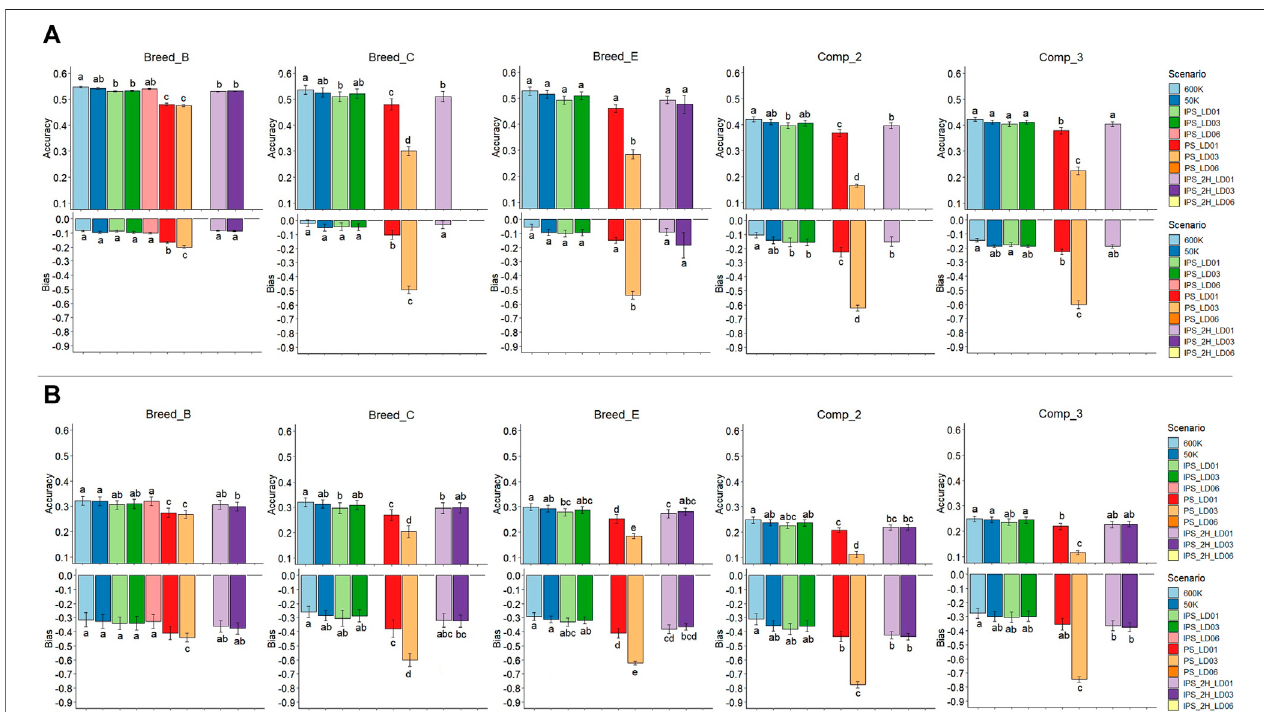
FIGURE 5 | Accuracies and bias of genomic predictions based on individual SNPs and haplotypes for the simulations of traits with moderate (A) and low (B) heritability(0.30and0.10,respectively).Breed_B,Breed_C,andBreed_E:simulatedpurebreedswithdifferentgeneticbackgrounds;Comp_2andComp_3:composite breeds from two and three pure breeds, respectively. 600 K: high-density panel; 50 K: medium-density panel; IPS_LD01, IPS_LD03, and IPS_LD06: independent and pseudo-SNPs from blocks with LD thresholds of 0.1, 0.3, and 0.6, respectively, in a single genomic relationship matrix; PS_LD01, PS_LD03, and PS_LD06: only pseudo-SNPs from blocks with LD threshold of 0.1, 0.3, and 0.6, respectively; and IPS_2H_LD01, IPS_2H_LD03, and IPS_2H_LD06: independent and pseudo-SNPs from blocks with LD thresholds of 0.1, 0.3, and 0.6, respectively, in two genomic relationship matrices. Zero values for both accuracies and bias mean no results were obtained, due to poor quality of genomic information or no convergence of the genomic prediction models. The same lower-case letters mean no statistical difference comparing genomic prediction methods within population at 5% signi fi cance level based on the Tukey